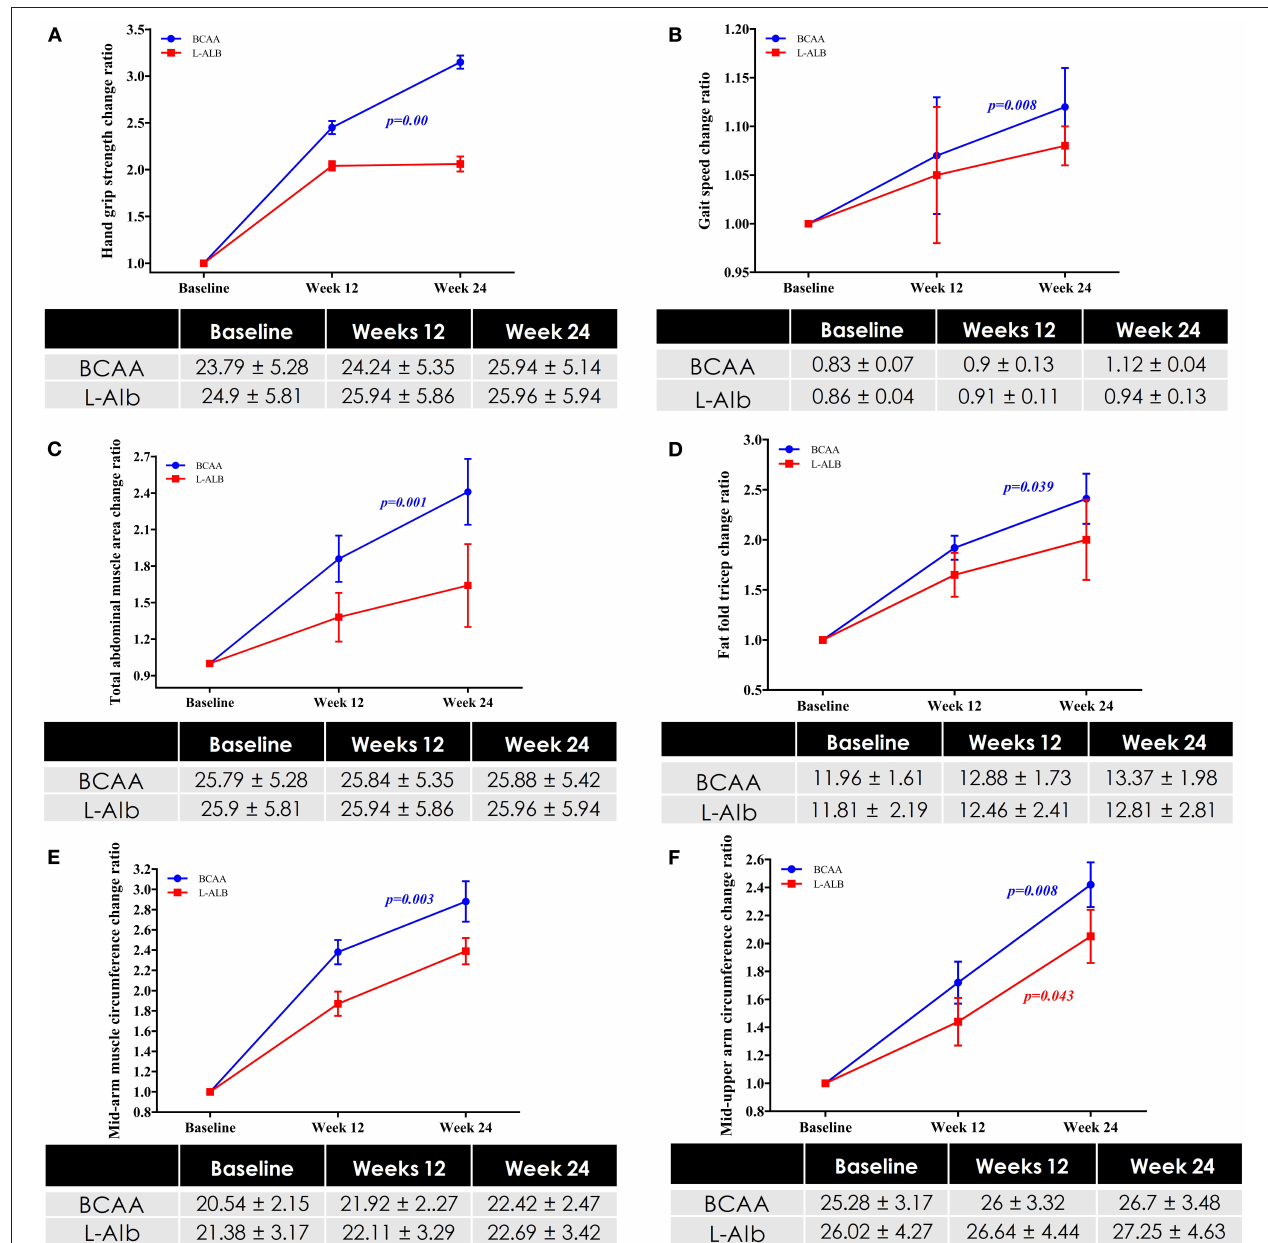
FIGURE 2 | (A) Changes in Hand-grip strength in BCAA and L-ALB group over a period of 24 weeks. (B) Changes in muscle function in BCAA and L-ALB group over a period of 24 weeks. Changes in muscle mass based on the different variables; (C) Total abdominal muscles area (TAMA) circumference; (D) Fat-fold triceps; (E) Mid-upper arm circumference; (F) Mid-arm muscle circumference in BCAA and L-ALB group over 24 weeks. Statistically significant at p < 0.05.